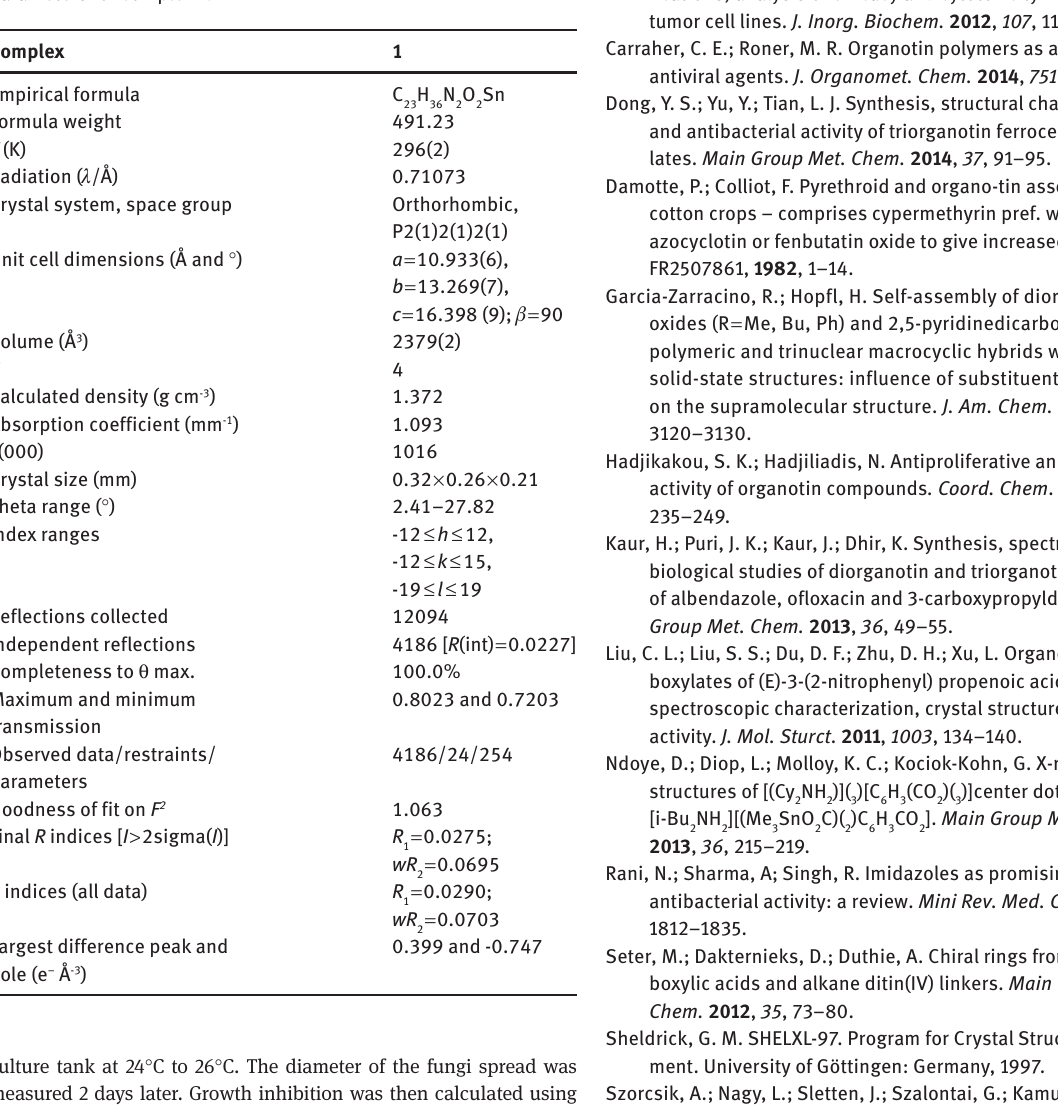
Table 3: Crystal data and details of structure refinement parameters for complex 1